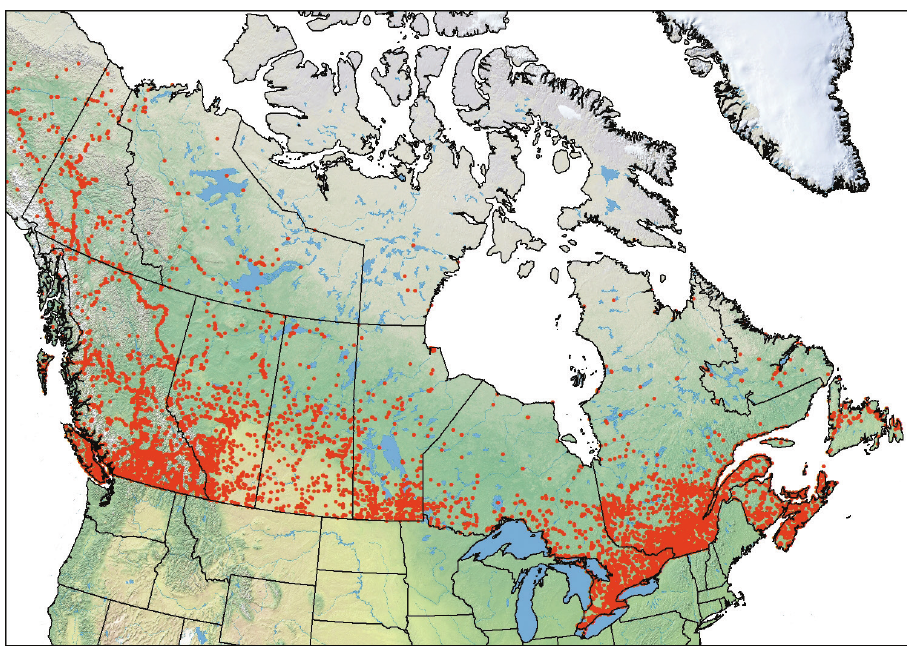
Figure 2. Collection points for the 375 species of Cerambycidae (Coleoptera) in Canada based on 81,555 records extracted from 106 Canadian and USA collections (Bousquet et al.